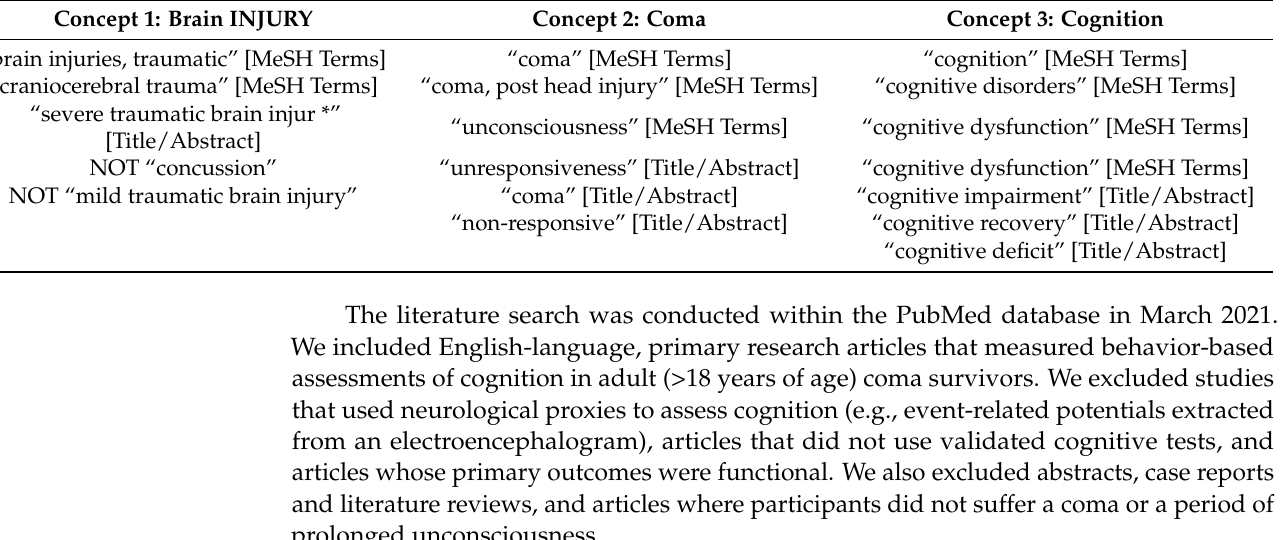
Table 1. Search strategy for cognitive outcomes of patients with a primary brain injury (Concept 1) following a period of unconsciousness. All terms in the table were included in the search. Concepts are separated into columns where each term in a column was separated by “OR” in the search and each column (concept) was separated by